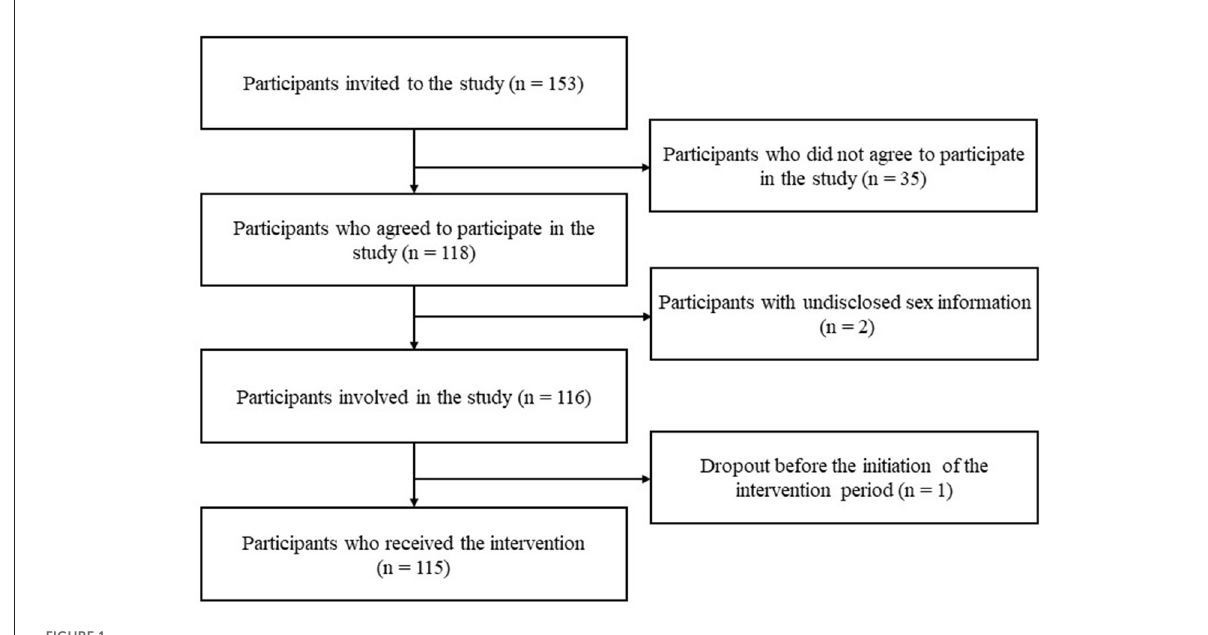
FIGURE1 Sampling flow